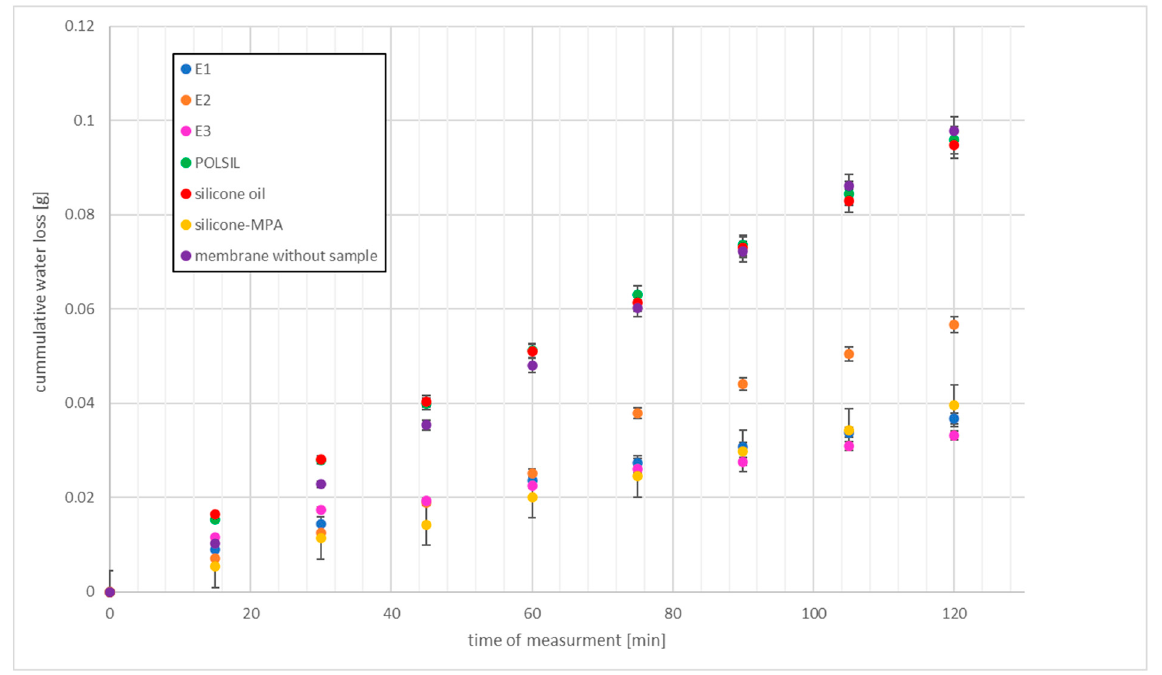
Figure 11. Change of cumulative water loss for analyzed oils, samples E1-E3, membrane without sample after 2 h in 15-min intervals, established by Payne Cup method.